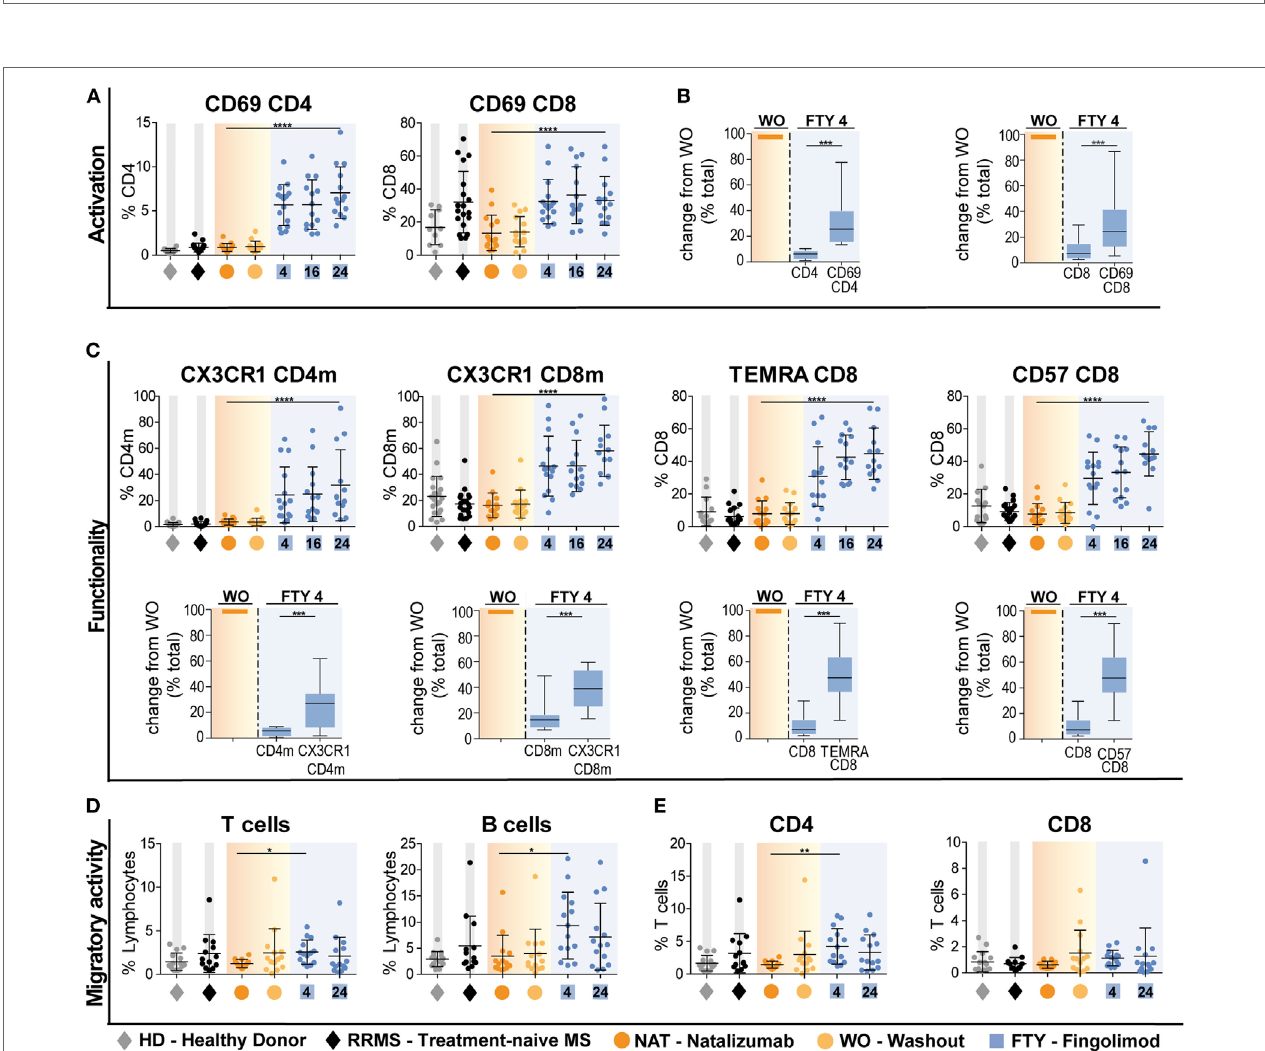
FigUre 3 | Preferential enrichment of terminally differentiated and functionally highly competent effector T cell subsets under fingolimod (FTY) treatment. All data ( n = 15) were assessed at baseline under long-term natalizumab treatment (NAT), after 8 weeks of washout without treatment (WO) and at time points 4 weeks (FTY4), 16 weeks (FTY16), and 24 weeks (FTY24) after onset of FTY treatment. Healthy donors (HD) and treatment-naive relapsing–remitting multiple sclerosis (RRMS) patients (RRMS) represent control groups. Scatter plots illustrate relative frequency changes (%) of (a) activation marker CD69 + CD4 and CD69 + CD8 T cells. (B) Change in absolute cell counts after treatment switch by comparison of FTY4 to the WO time point (in % total) of CD69 + CD4 and CD69 + CD8 counts to total CD4 and CD8 counts. (c) Relative proportions (in %) of flow cytometry data of functionality markers CX3CR1 + CD4 memory (CD4m) and CX3CR1 + CD8 memory (CD8m), TEMRA CD8 and CD57 + CD8 T cells comparing FTY to NAT treatment at indicated time points. Absolute change after treatment switch comparing CX3CR1 + CD4m and CX3CR1 + CD8m total counts to total CD4 and CD8 memory counts, as well as TEMRA + CD8 and CD57 + CD8 to absolute counts of CD8 at time points WO to FTY4 (in % total). (D,e) Transmigration assay was used to assess migratory capacity in percent, through human brain microvascular endothelial cell monolayer for 6 h in an in vitro model determined for (c) T cells and B cells, (D) CD4 and CD8 T cells comparing FTY and NAT treated patients to HD and RRMS controls. Values represent mean ± SD. Statistical significance was evaluated by linear mixed model, Kruskal–Wallis test, and Wilcoxon matched-pairs signed rank test. * P ≤ 0.05; ** P ≤ 0.01; *** P ≤ 0.001; **** P ≤ 0.0001.